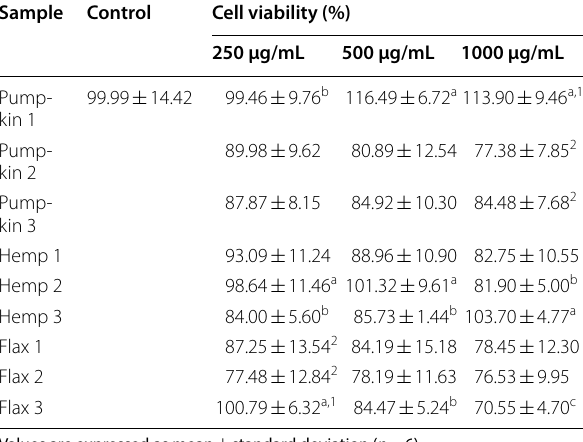
Values are expressed as mean standard deviation ( n 6) ± = Different letters (a, b, c) in the same row indicate significant differences between concentrations of the same sample extracted by different methodologies ( p < 0.05), according to Tukey’s HSD test Different superscript numbers (1,2,3) in the same species at the same concentration represent significant differences ( p < 0.05) between the extraction technique employed ( p < 0.05), according to Tukey’s HSD test. Subcritical water extraction carried out with a solid to solvent ratio of 1:30 (w/v), 1 h at 160 °C